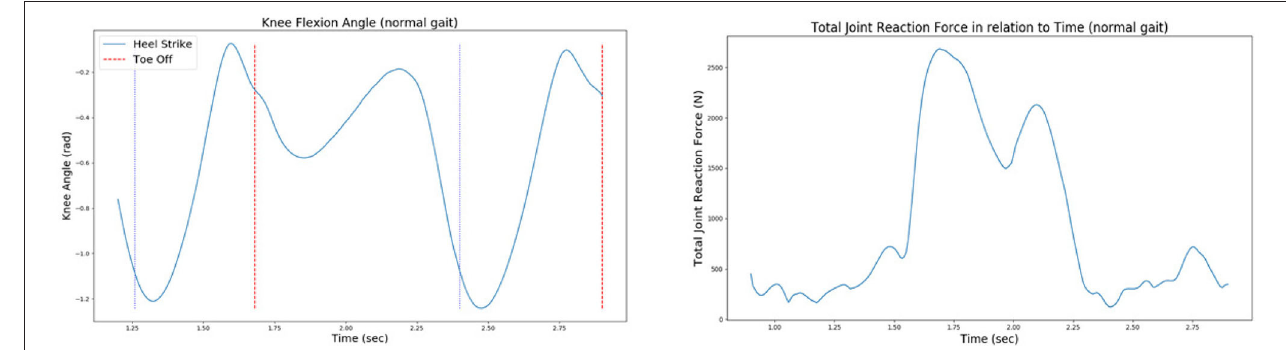
FIGURE 7 | The knee joint angle (left) and the total joint reaction force (right) of the patient’s right knee during normal gait, as extracted from the 6th GCC data